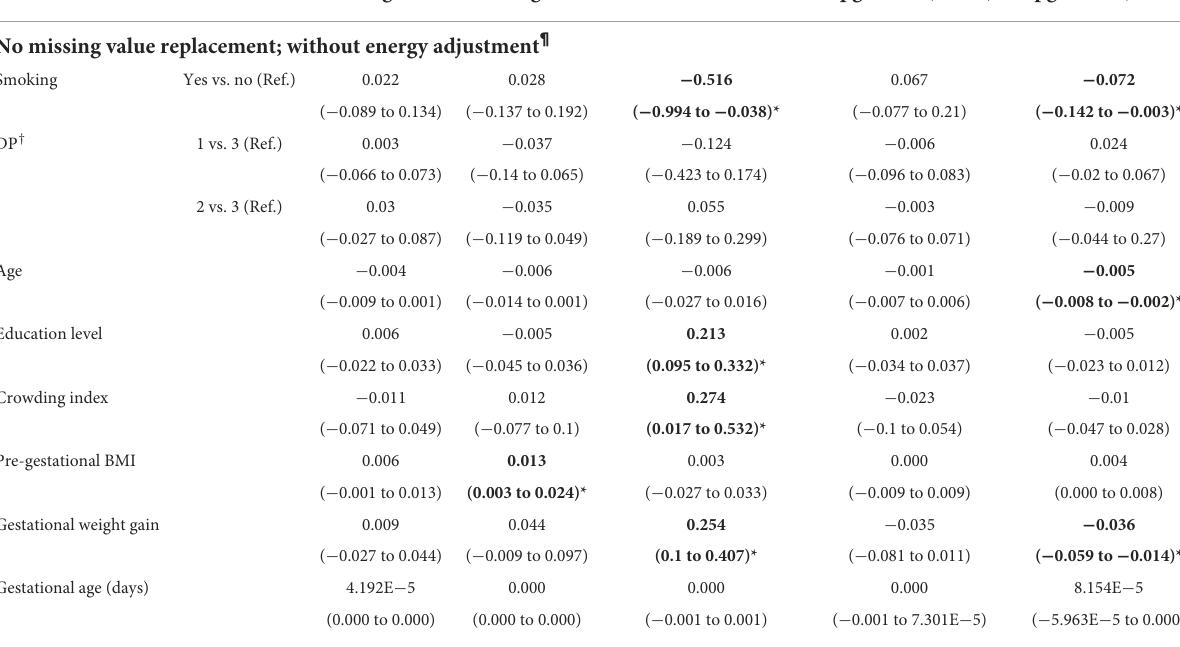
TABLE 10 Multivariate analysis of neonatal